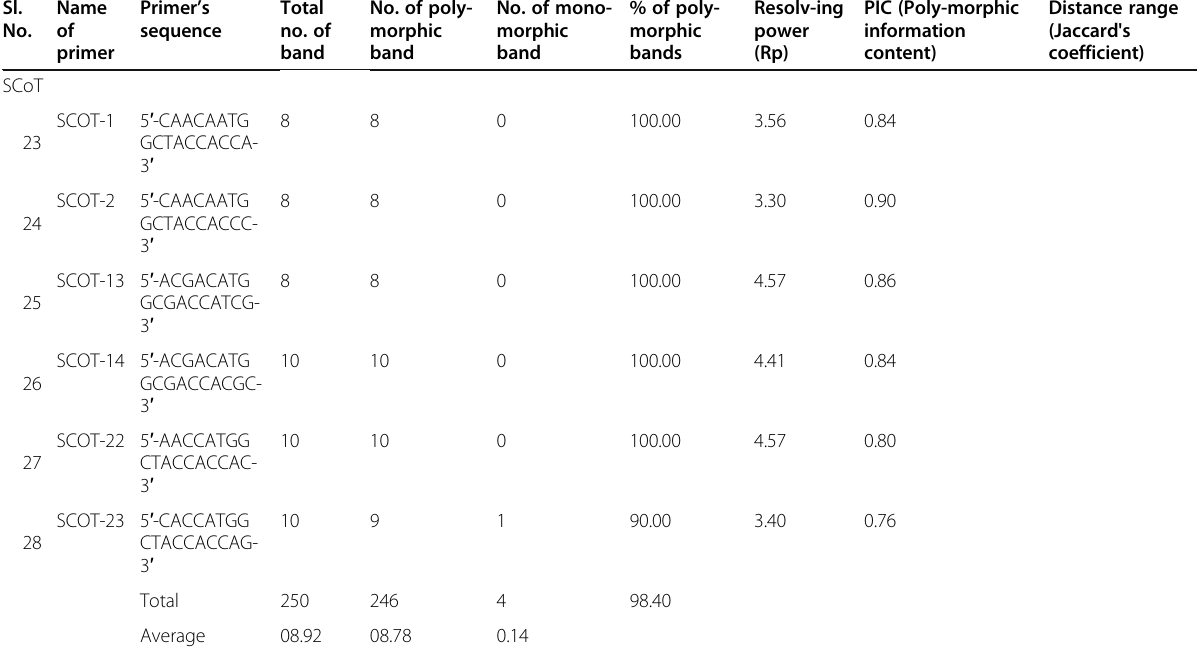
Table. 4 Extent of polymorphism as revealed by RAPD, ISSR, DAMD and SCoT primers (Continued) Sl. Name No.